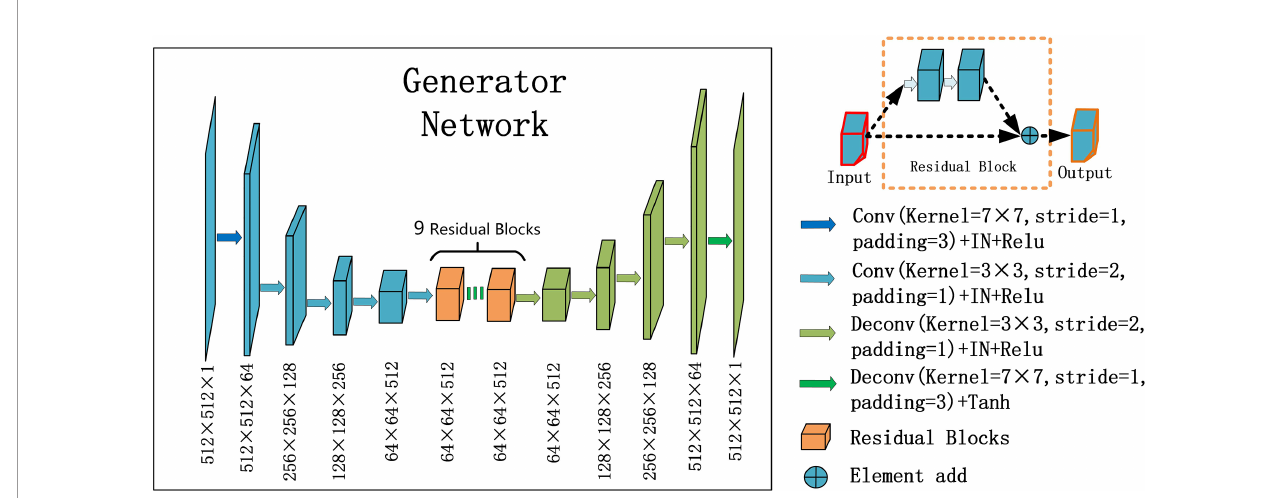
FIGURE 2 | U-net and residual blocks are used for the generators in CycleGAN. The input data size is 512 ×512 ×1, and the output data size is 512 × 512 × 1. The fi rst two digits represent the resolution, and the third digit represents the channel. Residual blocks are composed of 9 residual